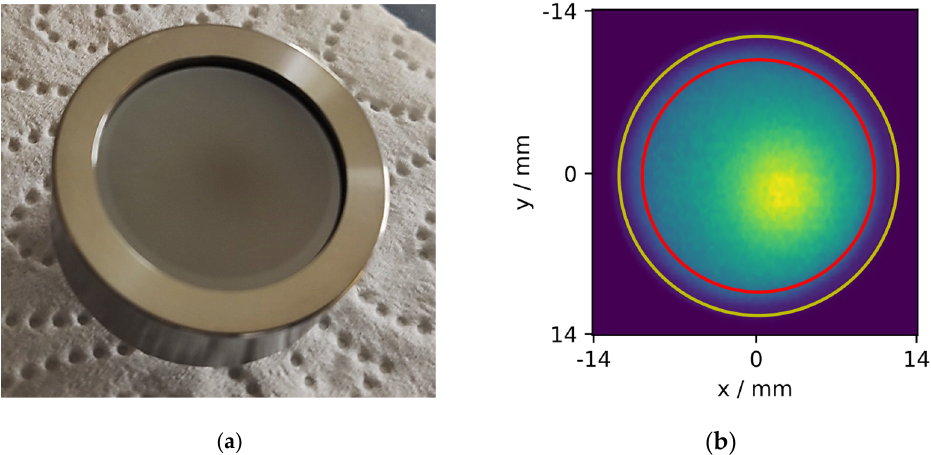
Figure 3. ( a ) shows a photograph of an IRSD based on a 450 mm 2 Canberra PIPS ® detector, modified with a layer containing 440 Bq 226 RaCl 2 . ( b ) shows a digital autoradiograph obtained from such a deposit where the inner diameter of the recessed Si-surface is given in yellow and the diameter of the shadowing aperture is given in red.